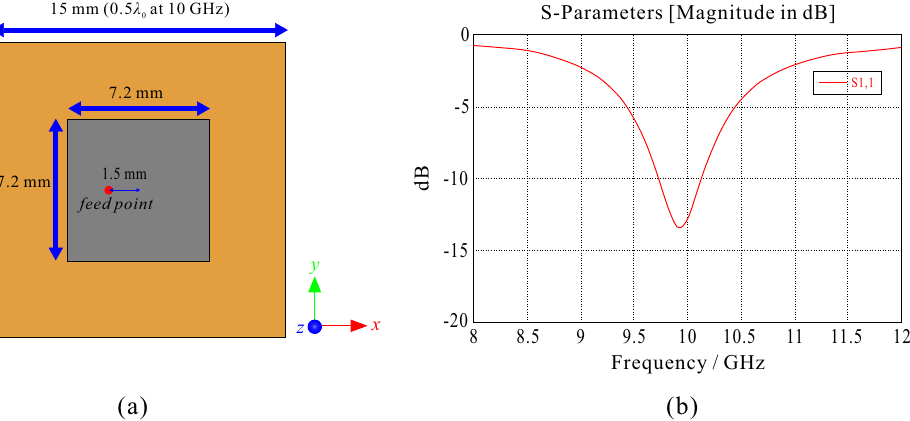
Figure 1. Single element information used for conformal-array characteristic analysis: ( a ) element type, ( b ) S-parameters